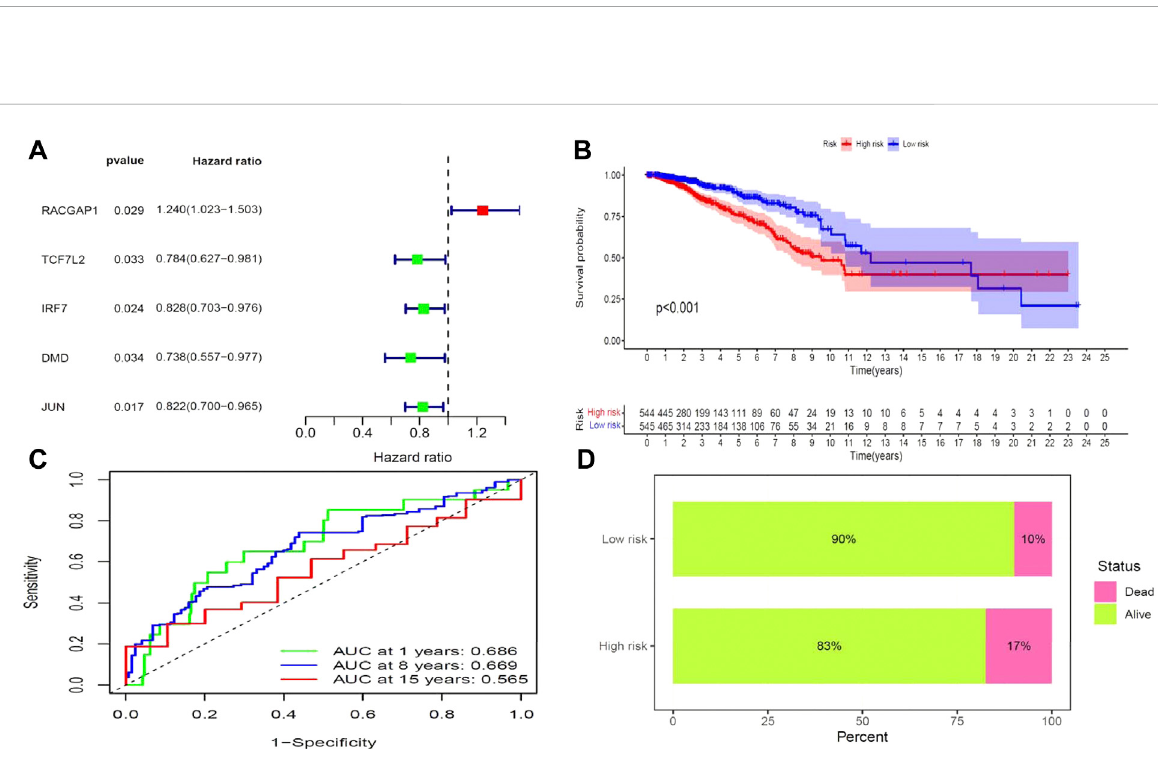
and the Gasteiger charge of merging non-polar hydrogen atoms (Johnson et al., 2015). Finally, the raw pdb fi le was converted into a PDBQT fi le format (Trott and Olson, 2010). Adjust the